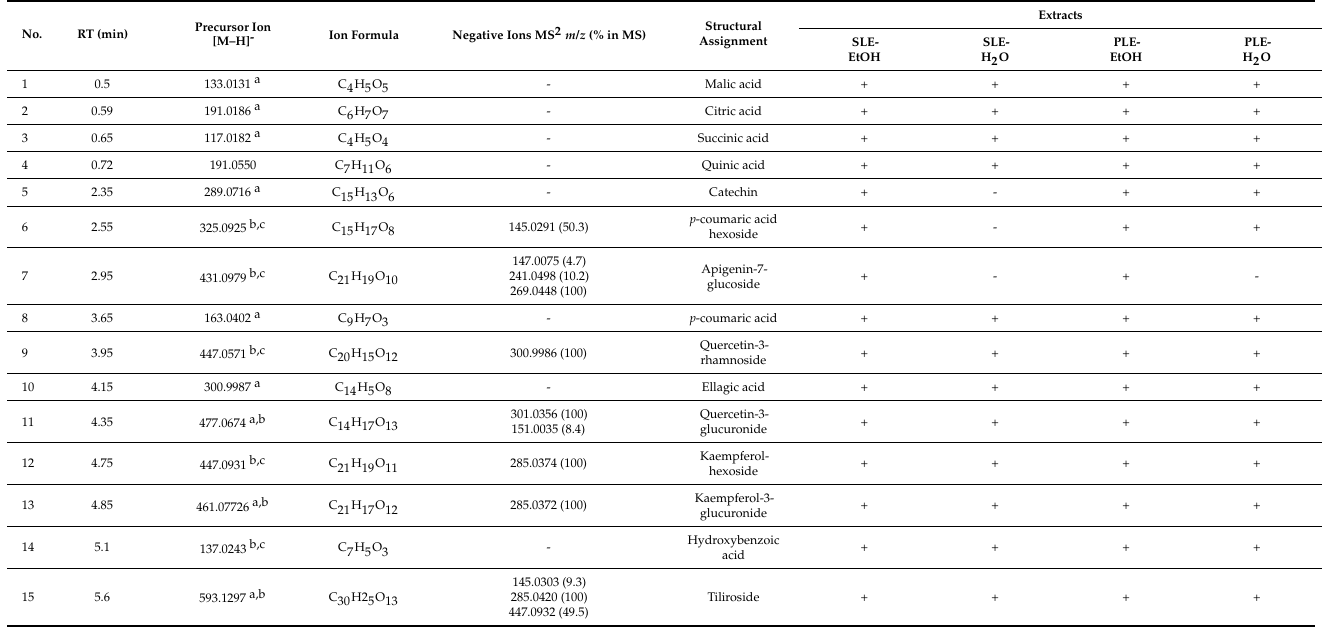
Table 1. The main constituents of strawberry pomace extracts identified by the non-targeted UPLC-Q-TOF analysis: SLE—solid-liquid extraction; PLE—pressurized liquid